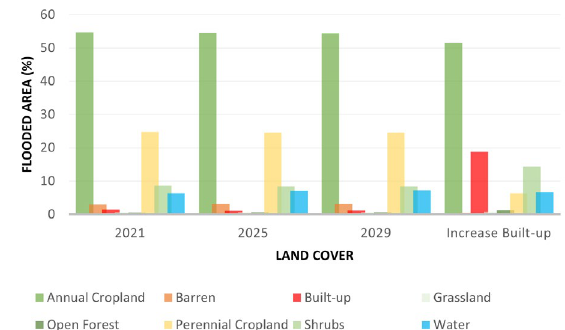
Figure 18. Flooded areas for each land cover with a 100-year rainfall return